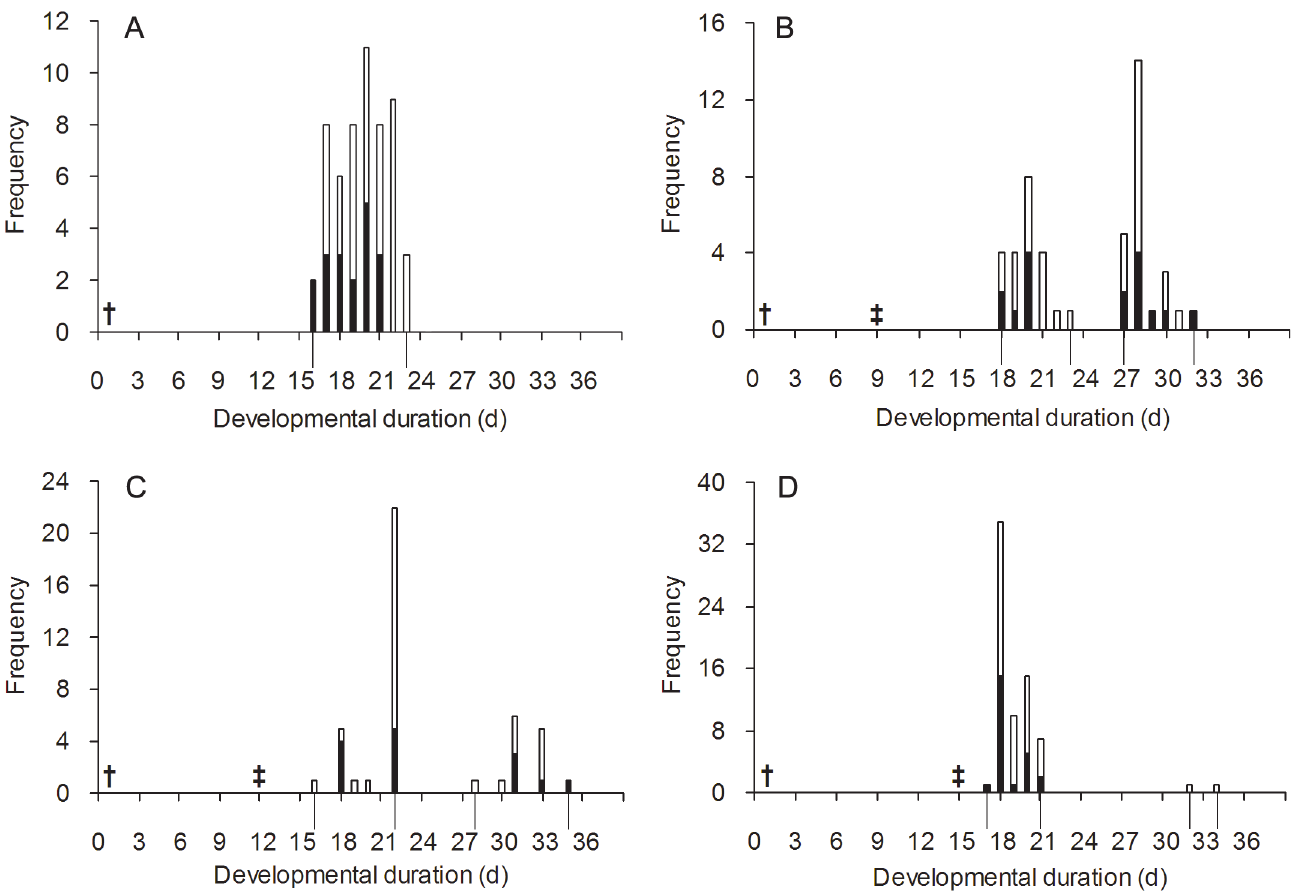
Fig 1. Frequencies of developmental duration of P . vindemmiae offspring. A: exposed only once; B-D: exposed twice with nine, twelve and fifteen day intervals. † and ‡ indicate primary and secondary exposure, respectively. Open and solid bars indicate females and males, respectively. Offspring emerged at two different events when the two exposures occurred with different time